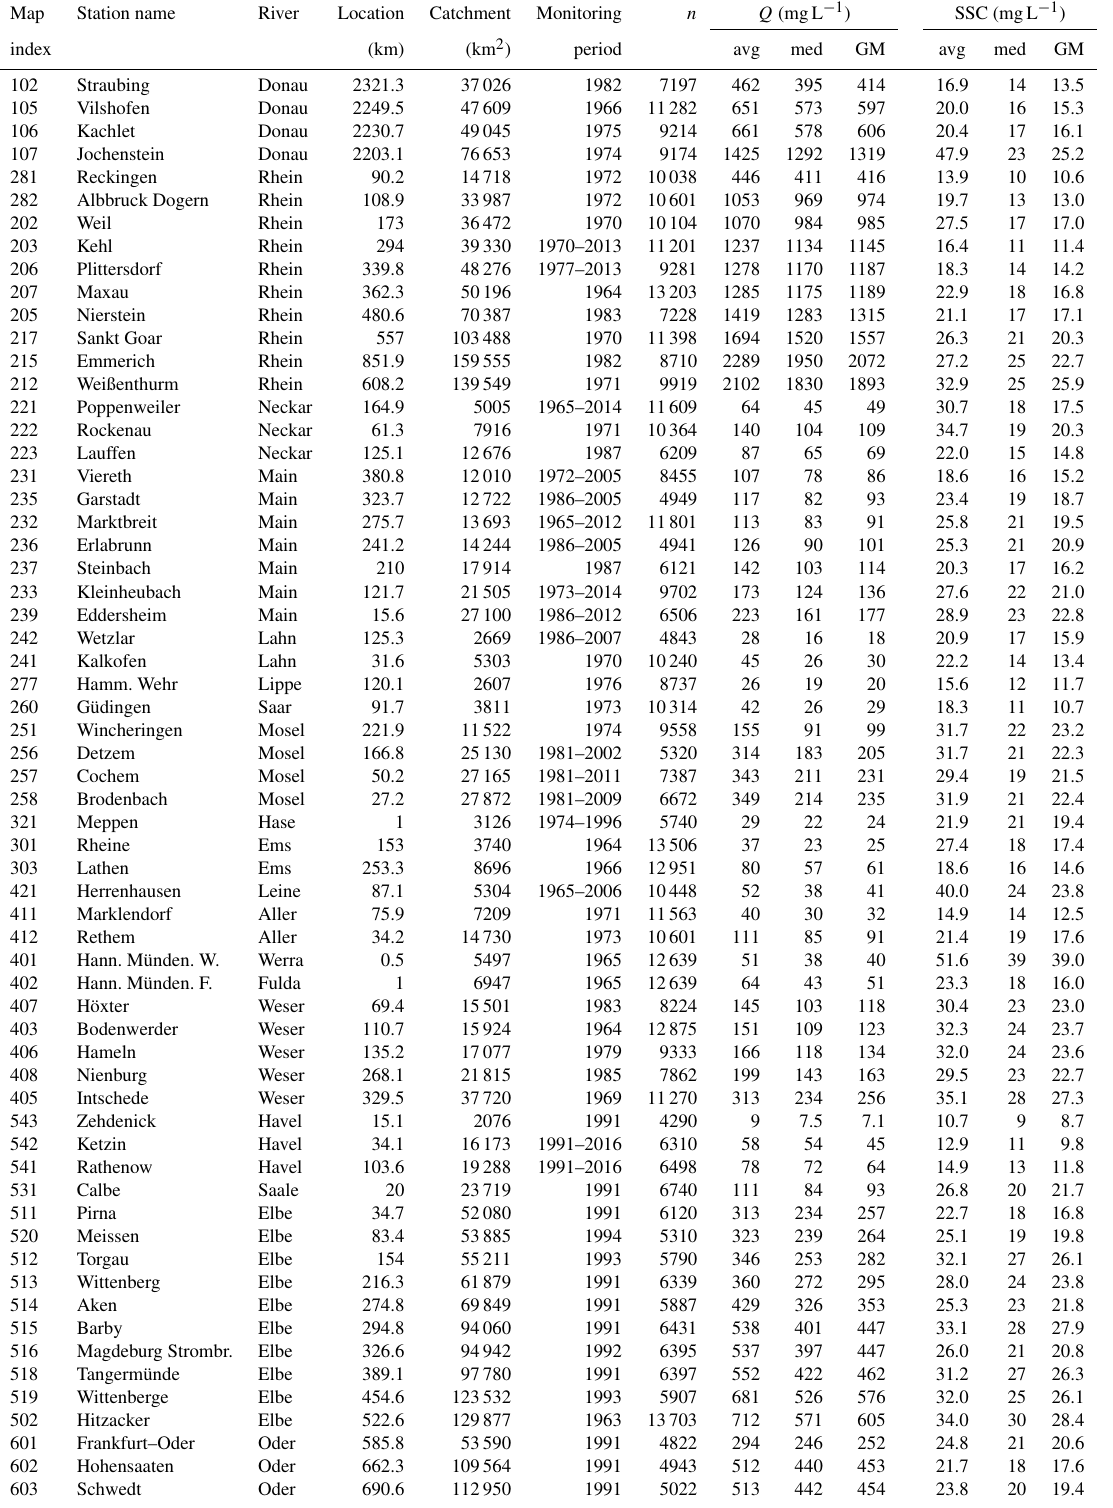
Table 1. Overview of sampling locations, contributing catchment size, monitoring period, number of samples ( n ), and average (avg), me- dian (med), and geometric mean (GM) of discharge Q and suspended sediment concentration (SSC). The map index refers to the numbers in the map (Fig. 1). The location (km) refers to the official kilometer measurement of the German Water and Shipping Authority of the waterways in downstream distance. The monitoring period refers to the start year if only one year is given. In this case monitoring continues until the